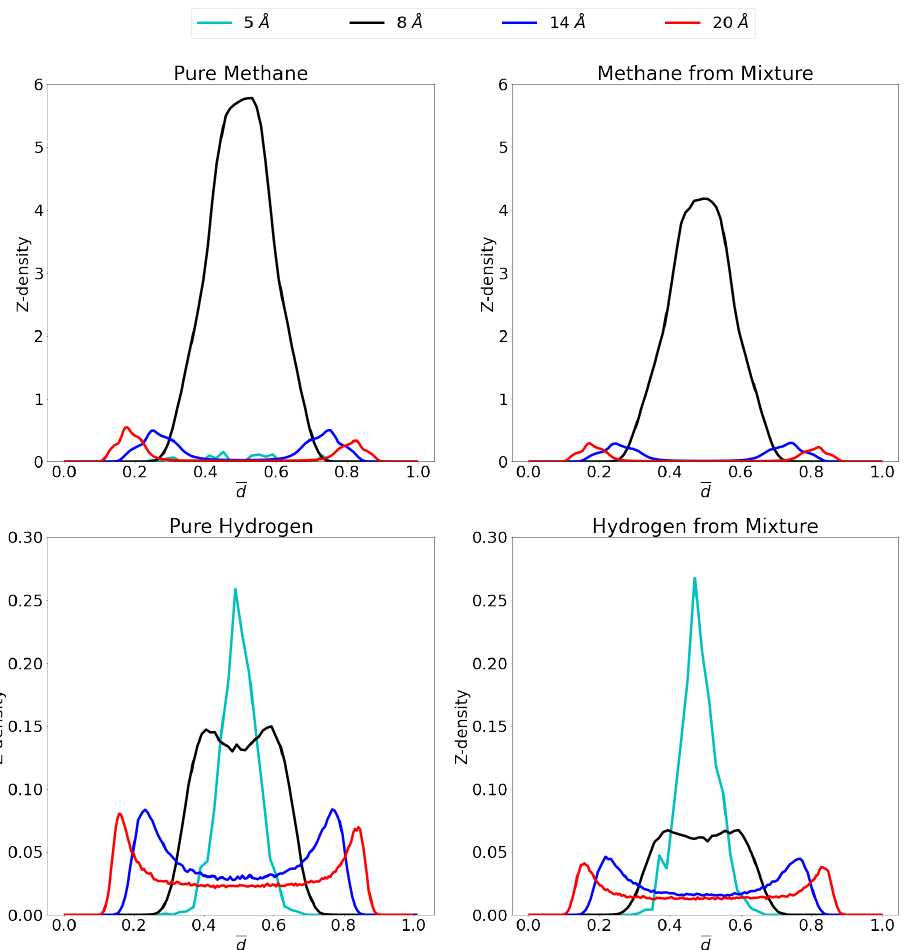
Figure 6. Z-density profiles at 1 atm for pure methane ( top left ), methane in the mixture ( top right ), pure molecular hydrogen ( bottom left ) and molecular hydrogen from the mixture ( bottom right ) in the different considered pores at 300 K. Reduced distance units are used so that the graphene sheets of the pores are located at 0 and 1 on the x-axis. Please notice the different scales on the y-axes. For pure methane at a pressure of 1 atm, it is seen that close to no molecules are adsorbed in the 5 Å pore, while a single, strong adsorption layer is present in the middle of the 8 Å pore. For the larger pores, two different adsorption layers are found, one on either graphene sheet. It is seen that the adsorption layers for the 14 Å pore are positioned slightly further from the graphene sheets than in the 20 Å pore. This is presumably caused by the opposing graphene sheet in the 14 Å pore being closer than in the 20 Å pore and pulling the adsorption layer slightly further from the ideal position to the closest graphene sheet. The simulated molecular distribution is very similar in nature as in the simulations reported by Yu et al. [64] for a 10 Å and 20 Å pore as well as the center of mass probability distributions for methane adsorbed in graphene reported by Collins et al. [65]. For